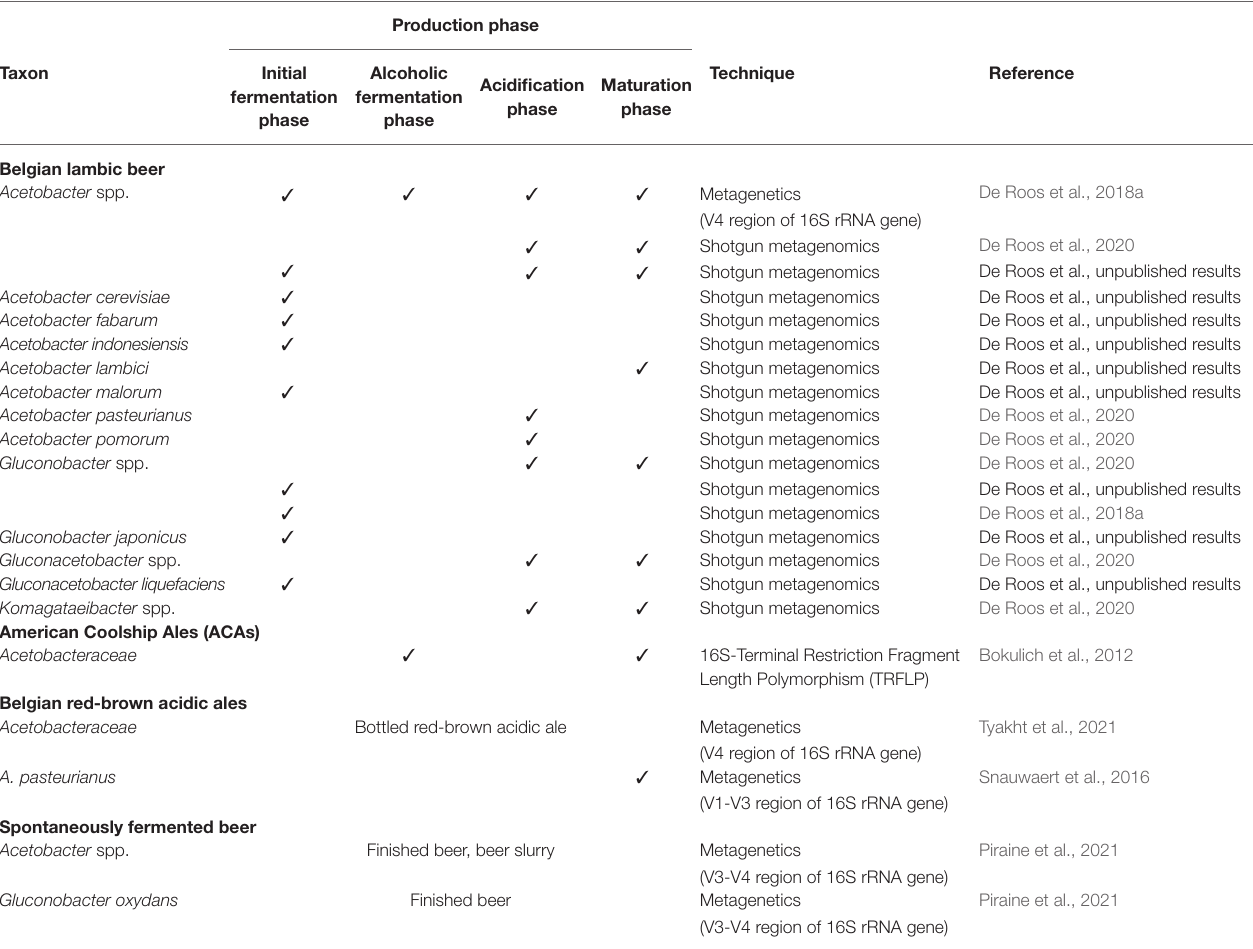
TABLE 2 | Overview of acetic acid bacterial species identified culture-independently from sour beers.